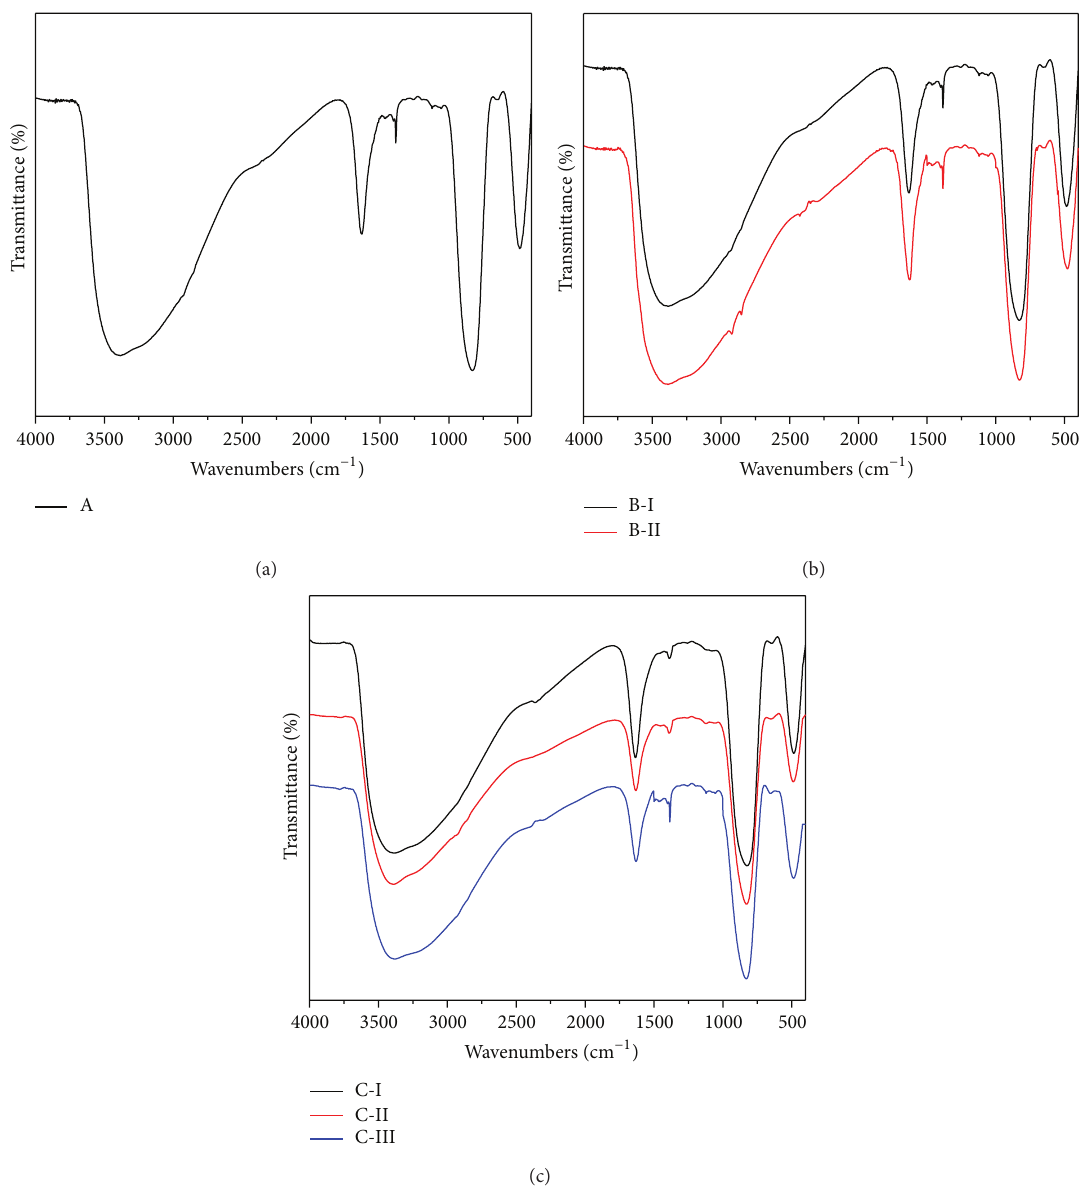
Figure 6: FT-IR spectra of the Fe-As (V) samples in different dosing modes (pH